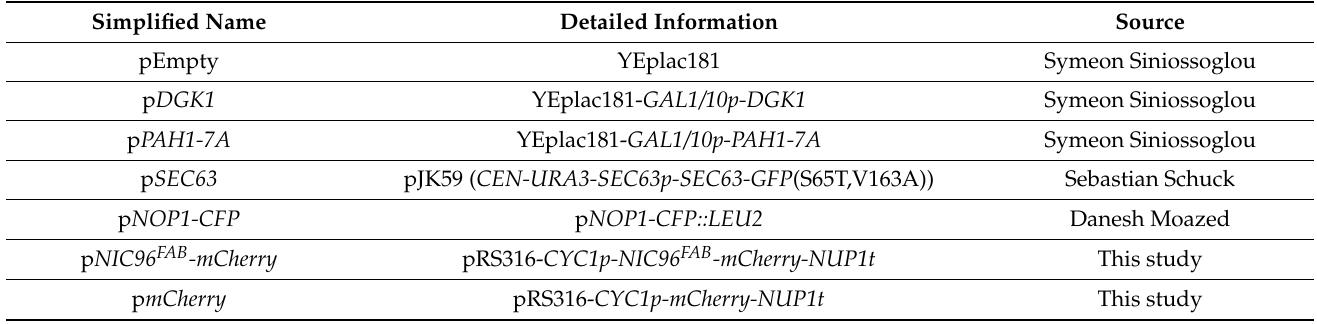
Table 2. Plasmids used in this